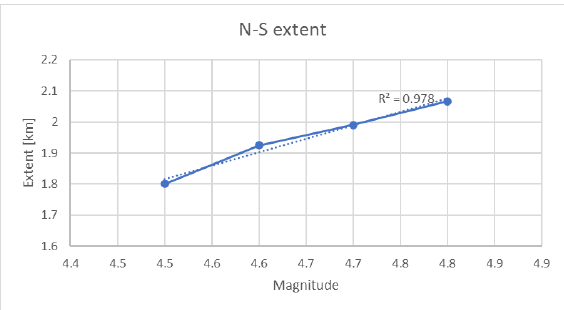
Figure 5. Graph of mean extent of deformation areas in N-S direction and registered magnitude of seismic